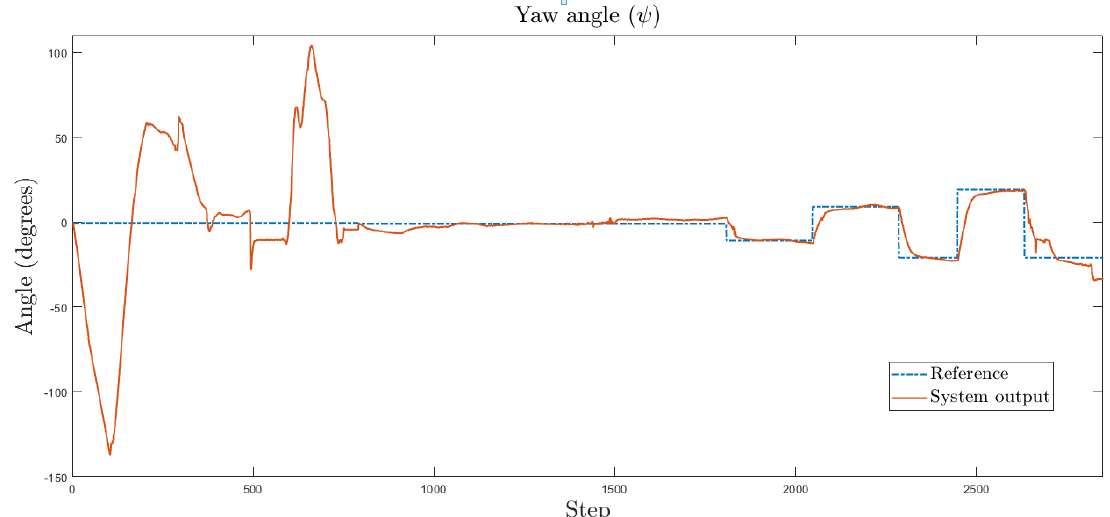
Figure 13. Experimental results for yaw angle of the UAV. Dashed line represents the reference and the solid line represents the system